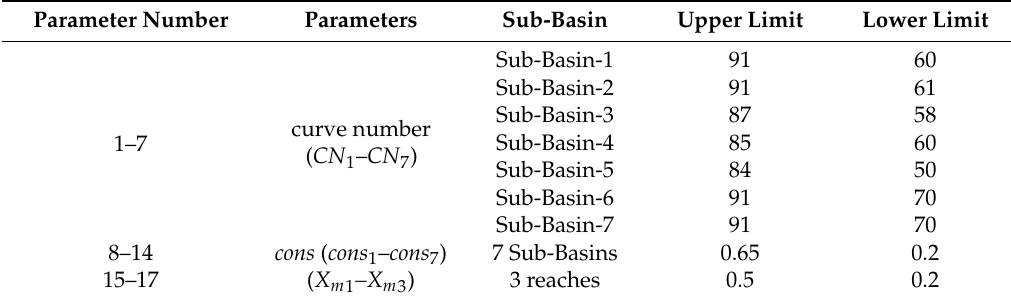
Figure 3. Hydrographs and hyetographs for the four flood events, occurred in a chronological order denoted by ( a ), ( b ), ( c ), and ( d ) respectively, in Tamar sub-basin. The dark blue bars exhibit rainfall and the dark curves represent the observed discharge hydrographs. Table 2. The initial upper and lower bounds of the considered parameters for calibration in seven sub-basins joined by three